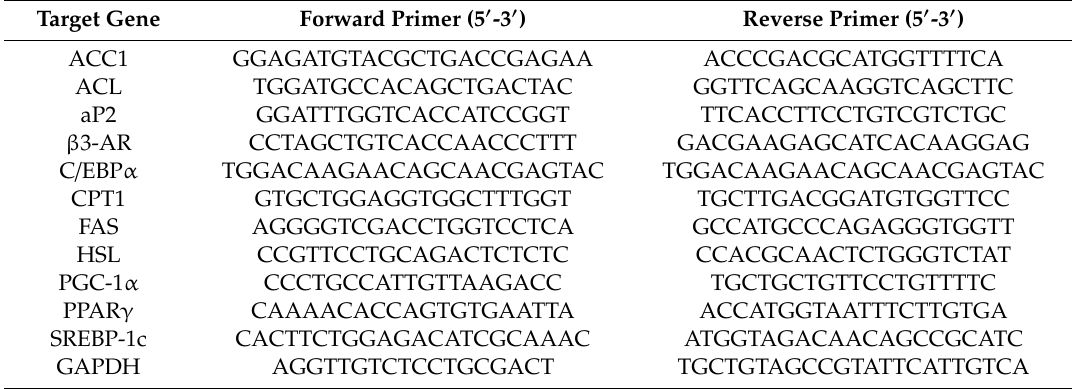
Table 1. Primer sequences used in this